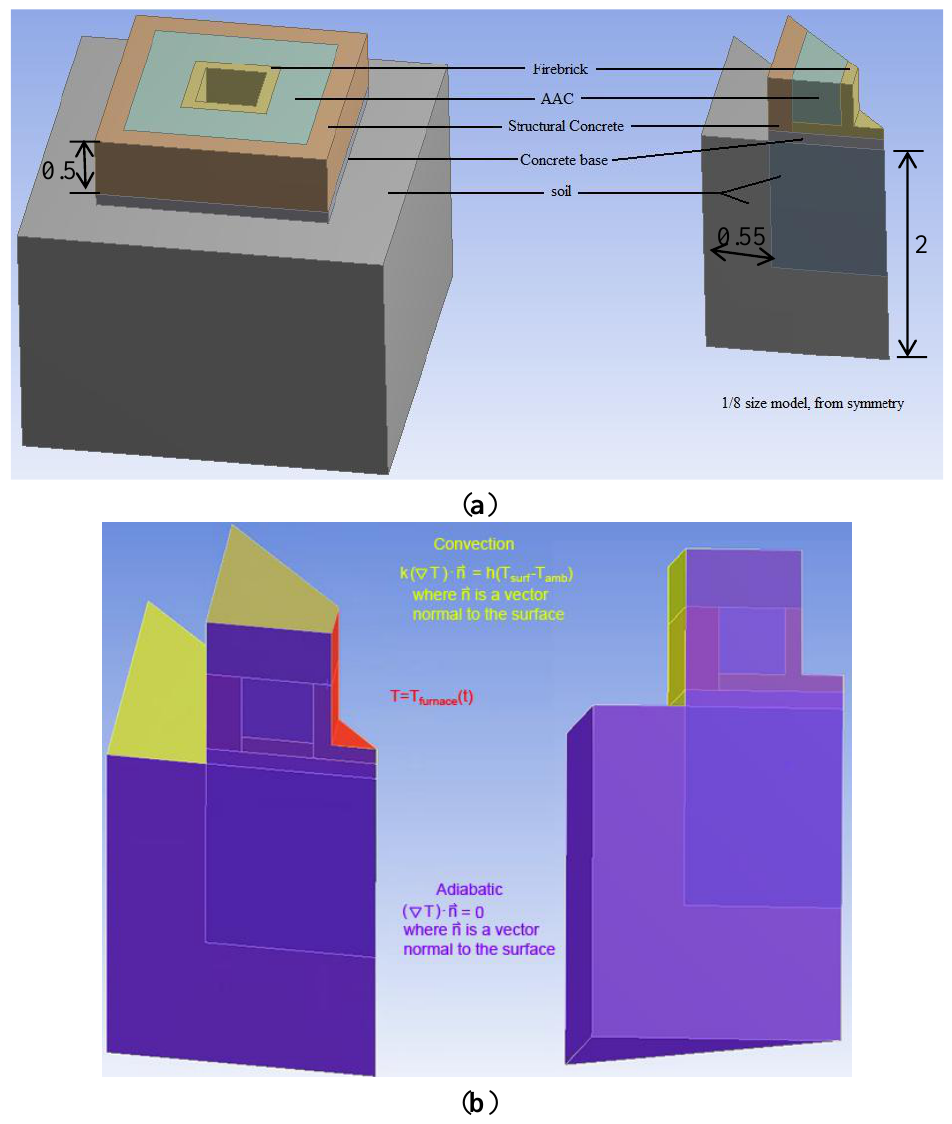
Figure 3. ( a ) Geometry of the finite-element model (dimensions in m); ( b ) Boundary conditions applied to different surfaces.